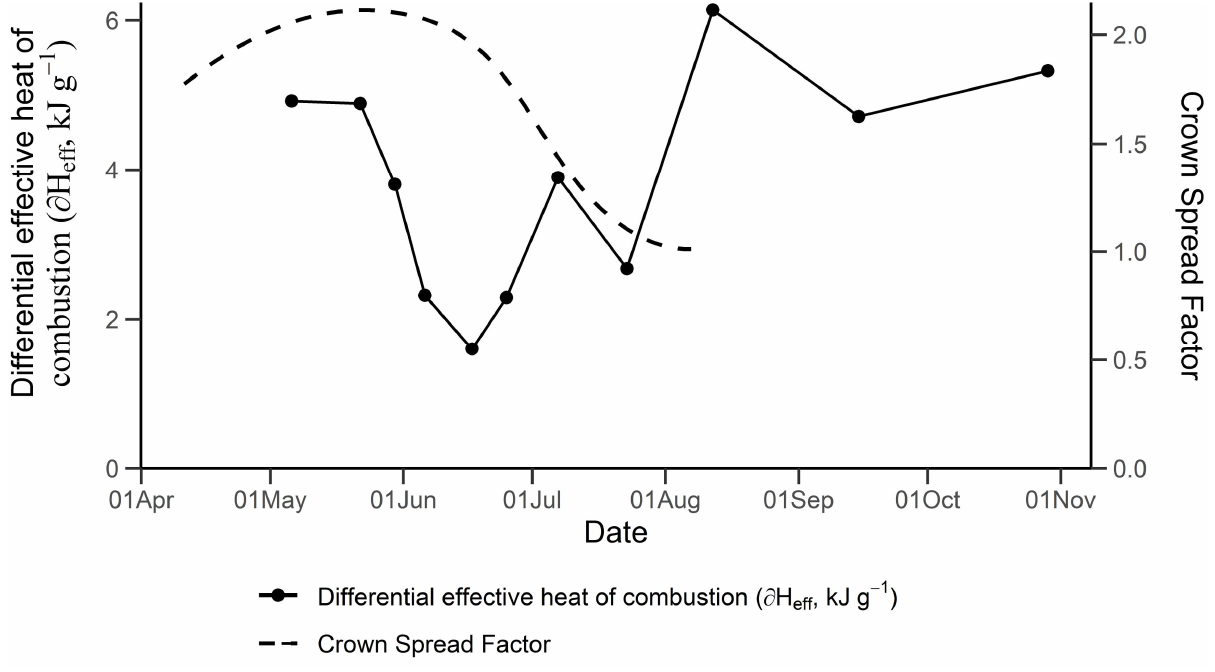
Figure 9. Seasonal changes in live fuel flammability as measured in our study as differential effective heat of combustion ( ∂ H eff ) for 2014 (solid line) and as assumed by the FBP model when expressed as an FMC-derived Crown Spread Factor (dashed line). The FPB model assumes only one seasonal maximum in live fuel flammability around 1 June. Flammability measured in this study indicates the first seasonal maximum three weeks earlier, in early May, which closely matches the historical seasonality of extreme crown fire behavior in Canada (Figure A2 and Table A1). In agreement with the historical seasonality of extreme crown fire behavior, flammability measured in this study indicates the second and the third seasonal maximums around 1 July and 1 August when the FBP model assumes lowest values of the